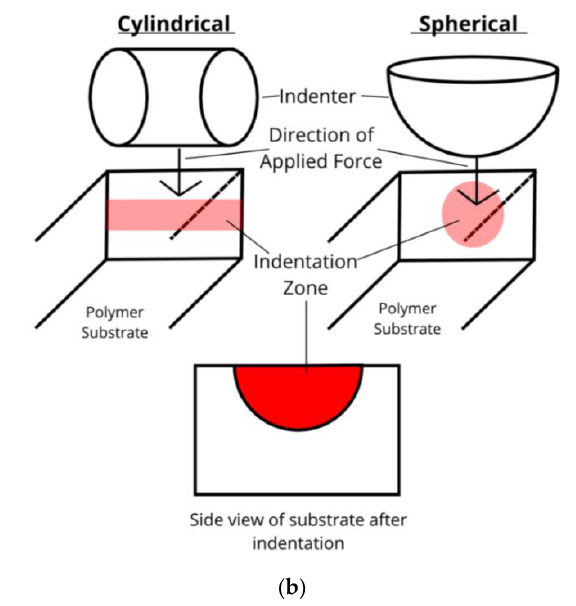
Figure 2. ( a ) Schematic of overall nanoimprint lithography (NIL) process for PS. ( b ) Cylindrical versus spherical indenter.